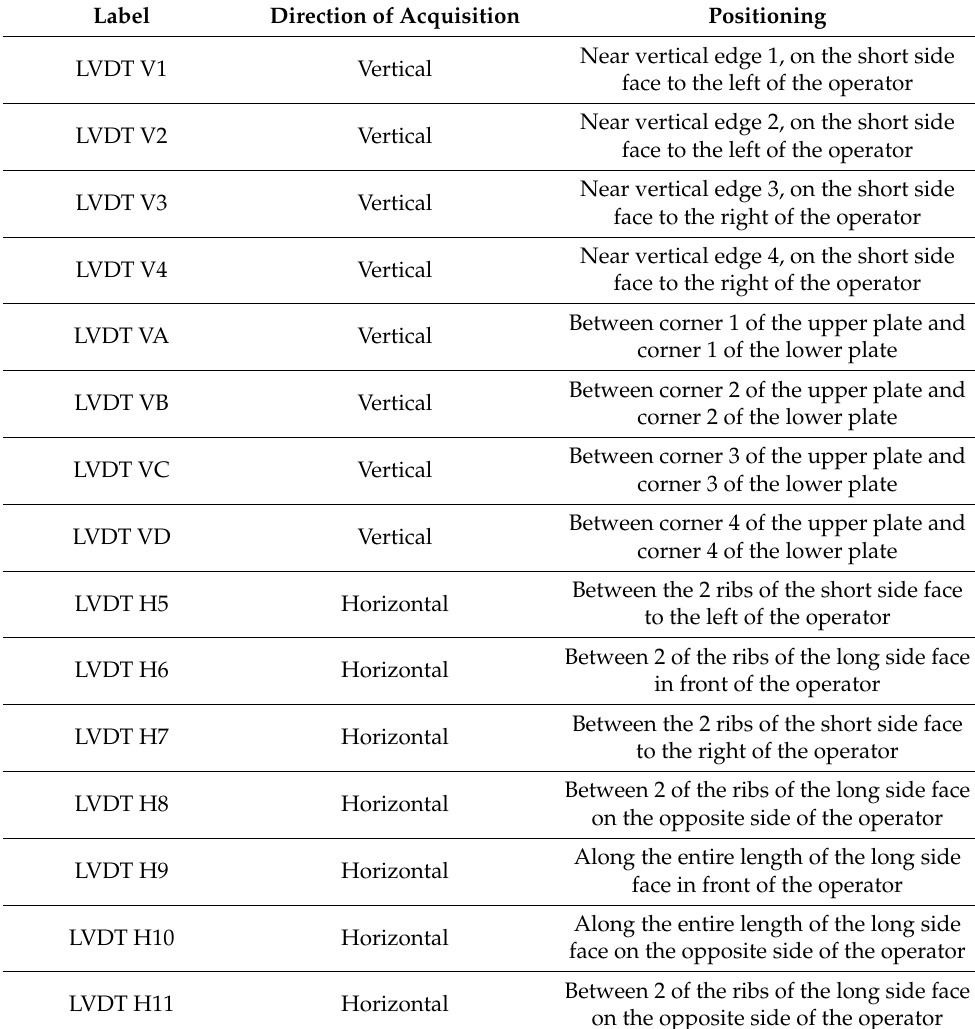
Table 3. Labelling and positioning of the 15 LVDTs: opposite corners of the upper and lower plates have the same